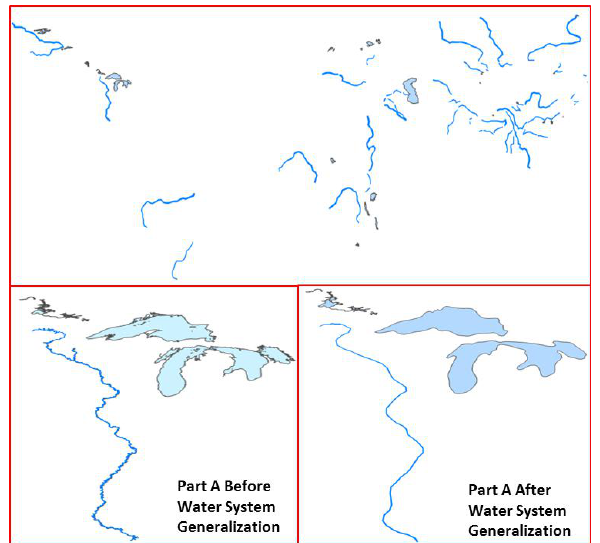
Figure. 10 Local Comparison of Water System Generalization